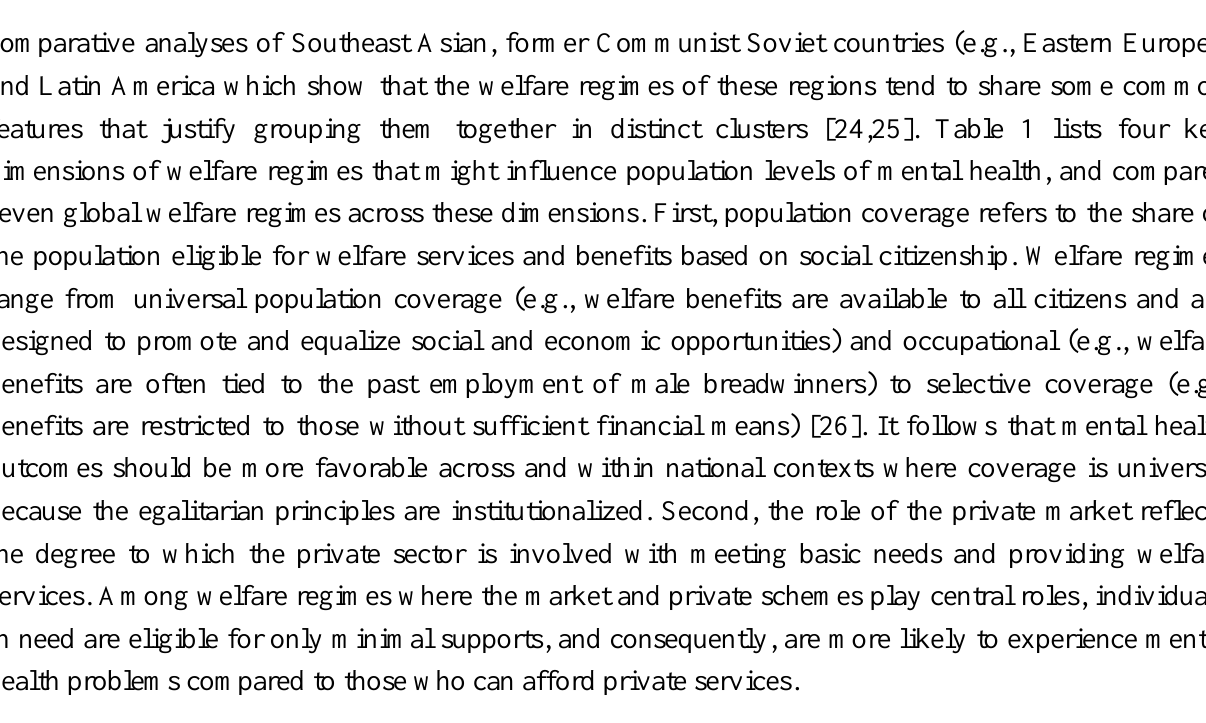
Table 1. General features of welfare state